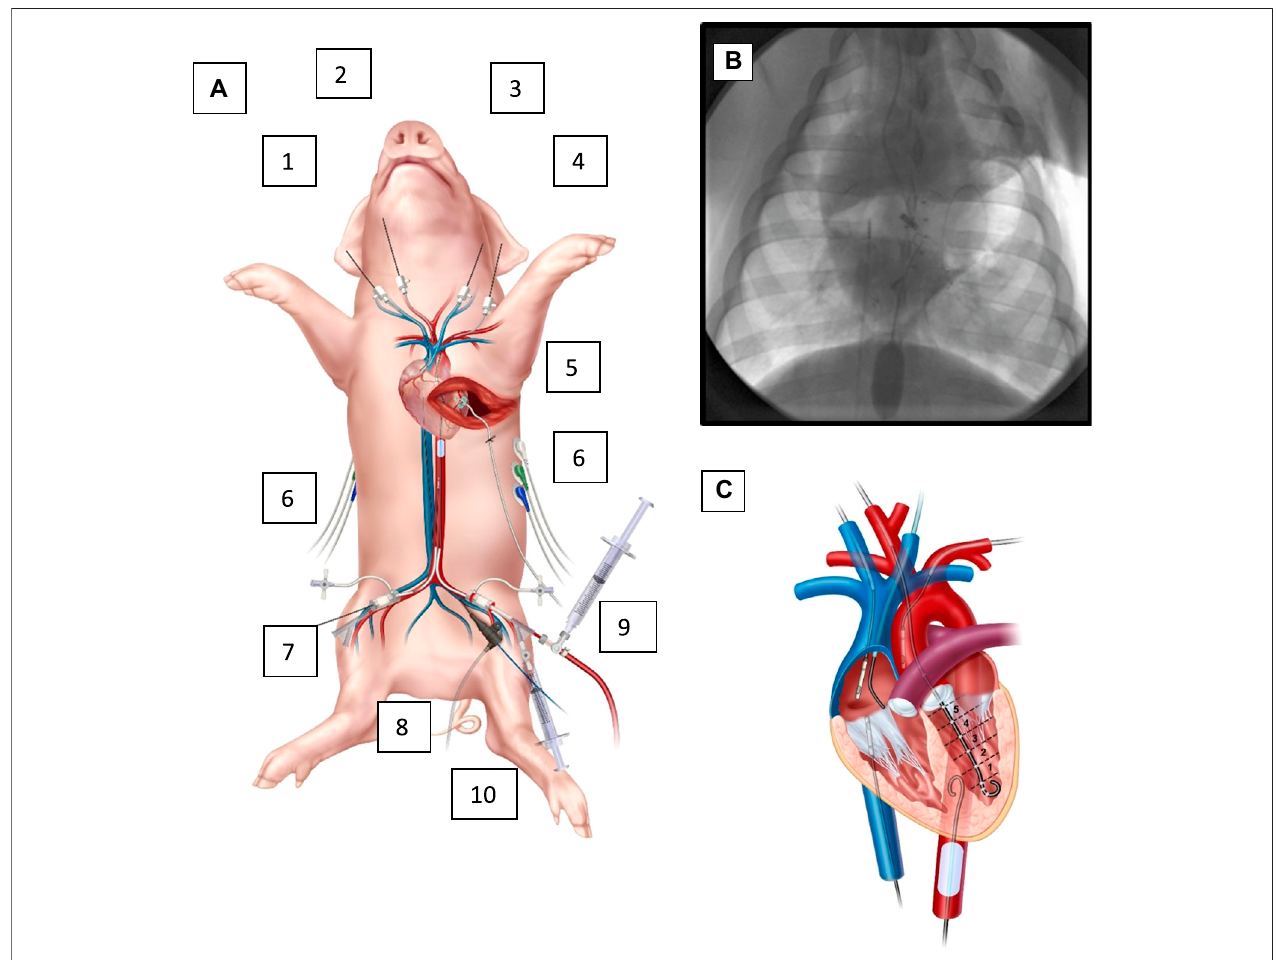
FIGURE 2 | Animal instrumentation and overview. (A) . Instrumented animal. (1) right IJ with 7 french (fr.) cannula in right atrium for central venous gases, (2) right carotid with 7 fr. cannula with left ventricle PV catheter, (3) left IJ with right atrial pressure monitor and (4) left brachial artery with aortic (above the REBOA) pressure monitoring.Also,with anantero-lateral thoracotomywithadissected left coronary; (5)a fl owprobe around theleftcoronary, and (6)EKG leadsonleftand right posterior chest. In the lower extremities, (7) right femoral artery with 7 fr sheath for an aortic pressure (below the REBOA), (8) a right femoral vein central venous catheter for controlled exsanguination, and (9) left femoral artery with9 fr. sheath for the REBOA catheter and (10) left femoral vein 7fr. Cannula for transfusions, medications, and IV fl uidsasneeded.Theanimalalsohasarectaltemperatureprobe,endotrachealtubeandoxygensaturationprobe(notshown). (B) .Fluoroscopicimageofthechestwhile instrumented,withtheREBOAin fl ated.Fromabove(left)anRAcatheterforcentralvenousgases,and(right)anaorticpressurecatheter(abovetheleveloftheREBOA),a central coronary fl ow probe with wire looped extra-corporally. From below, (left) CVP catheter in IVC, and (right) in fl ated REBOA in zone 1 of descending aorta. Not pictured isthe abdominal aortic pressure balloon, which is below the REBOA. (C) . Cartoon illustration ofthe central instrumentation. PV catheter in the LV, IVC pressure catheter, CVP catheter, and aortic pressure monitors, as well as in fl ated REBOA and RA catheter.